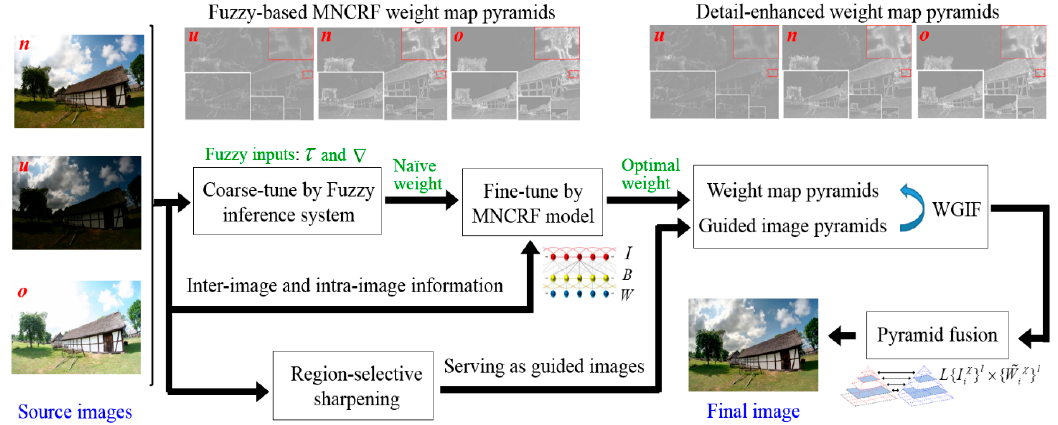
Figure 2. Overall framework of the proposed method, where u , n , and o, respectively, indicate under-exposure, normal-exposure, and over-exposure. For simplicity, we only show the pyramids of the red plane.